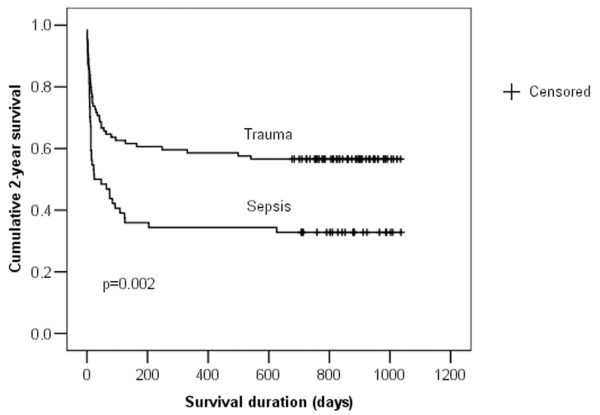
Cumulative 2-year mortality. The Kaplan-Meier survival curve shows that patients with sepsis had higher cumulative 2-year mortality than did patients with trauma.